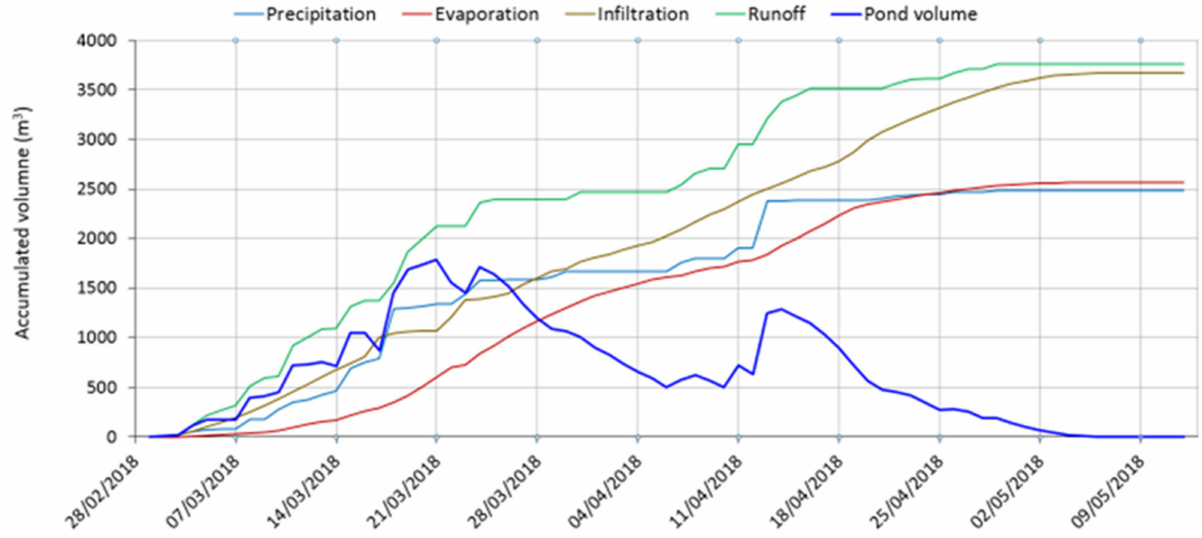
Figure 12. Temporal evolution of the elements of the water budget expressed as accumulated volumes. The evolution of the instantaneous volume stored in the pond is also